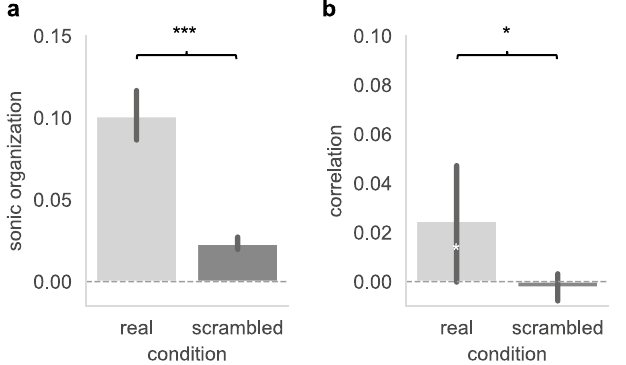
Figure 4. Coordination of musical actions. ( A ) The degree of sonic organization within the orchestra was measured as the absolute value of the correlation (Spearman’s rho) between pairs of musicians’ musical actions (playing versus not playing). Sonic organization highly significantly differed from chance level (t(104) = 9.69, p < 0.001, d = 1.35). ( B ) Correlations (Spearman’s rho) significantly differed from the chance-level computed from scrambled pairs (t(104) = 2.06, p = 0.042, d = 0.29) and from zero (t(104) = 1.99, p = 0.049, d = 0.19), although with a small effect size reflecting the fact that some pairs tended to be correlated, and other pairs to be anti-correlated. Error bars show 95% confidence intervals, black asterisks show the pairwise t-test comparing real vs. scrambled data (with ***p < 0.001) and white asterisks the one-sample t-tests comparing Spearman’s rho to zero (with *p <